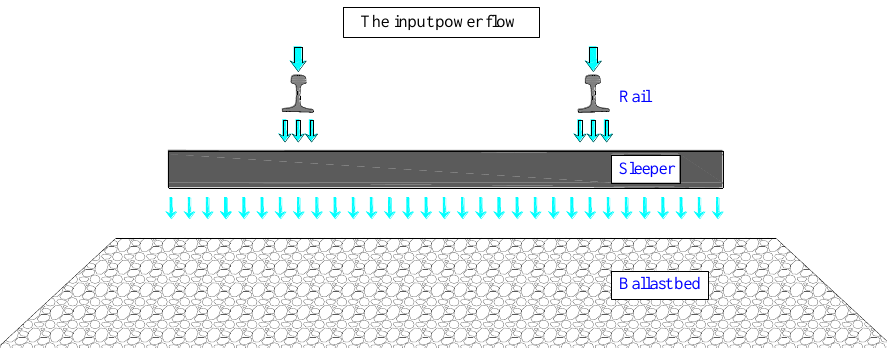
Figure 6. The transfer of the power flow.